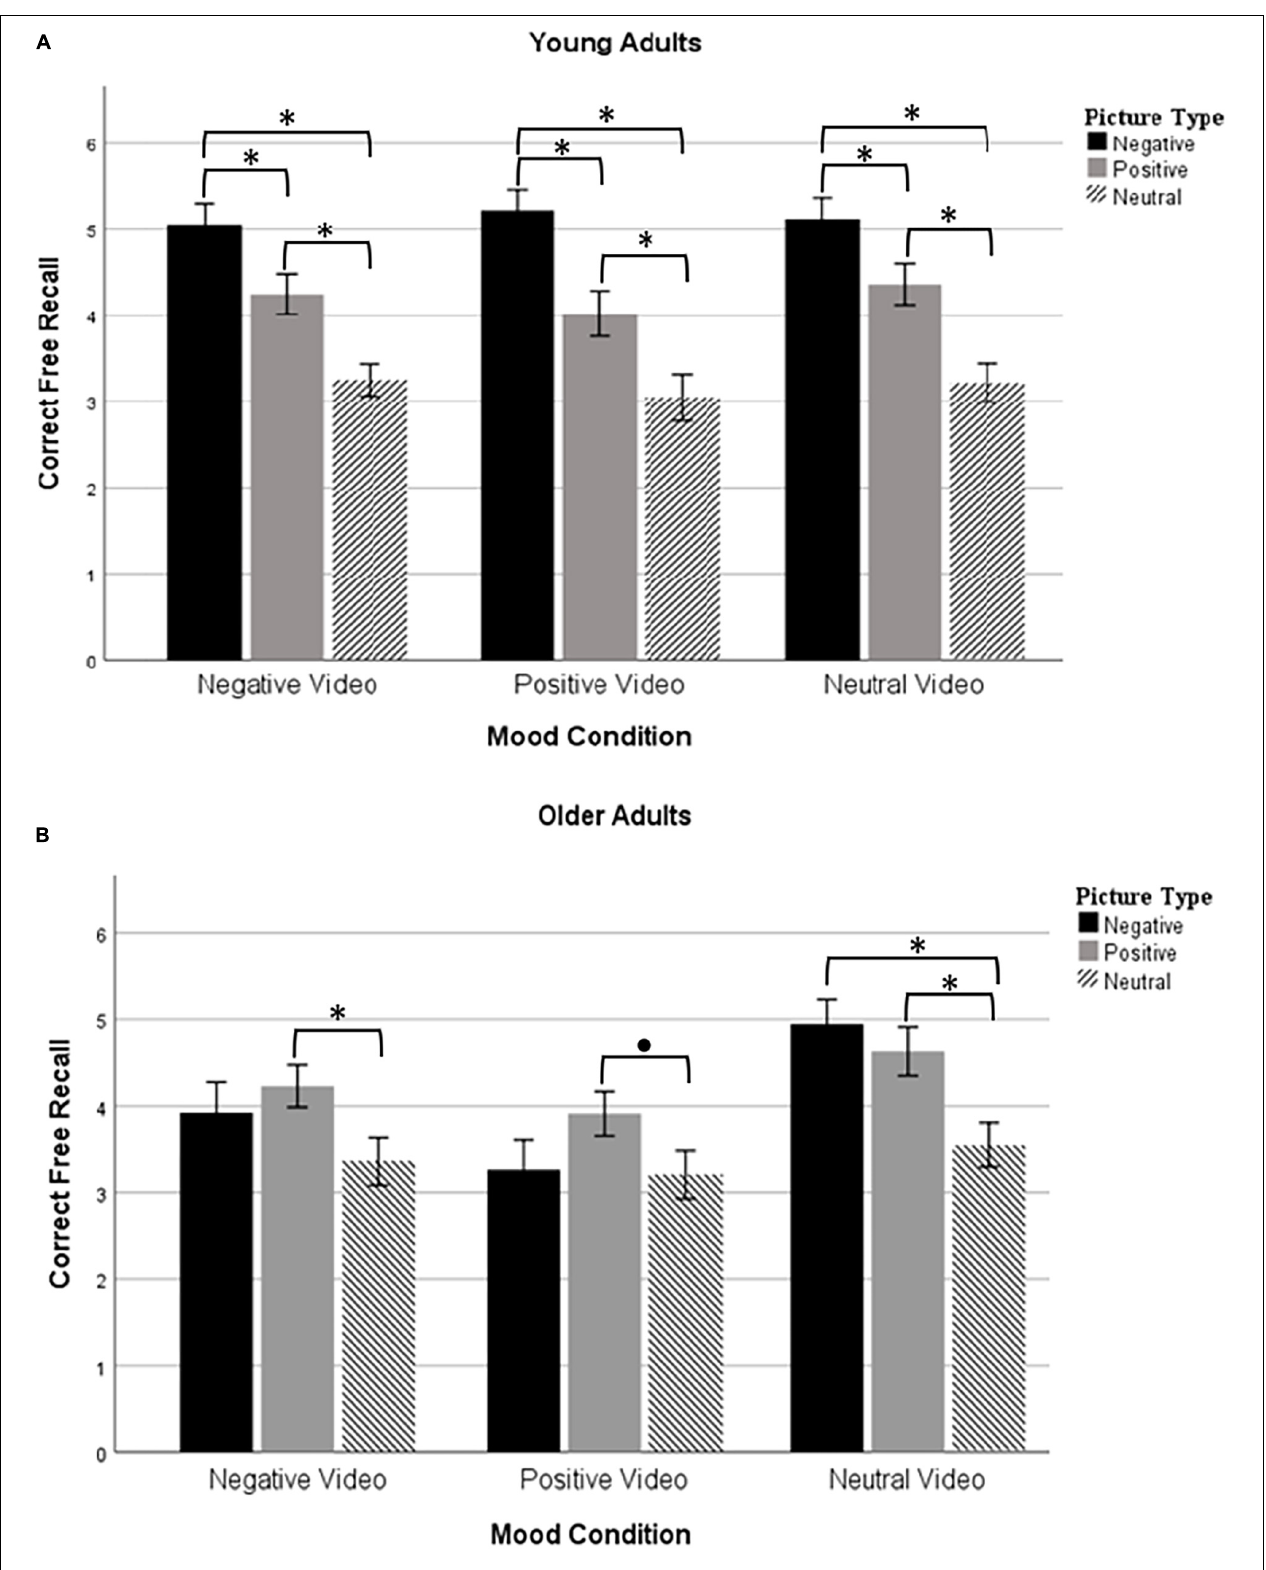
FIGURE 1 | Mean correct recall in young adults (A) and older adults (B) after watching either a negative, positive, or neutral video. ∗ p < 0.05 and • p < 0.10 after Bonferroni adjustment for multiple comparisons.